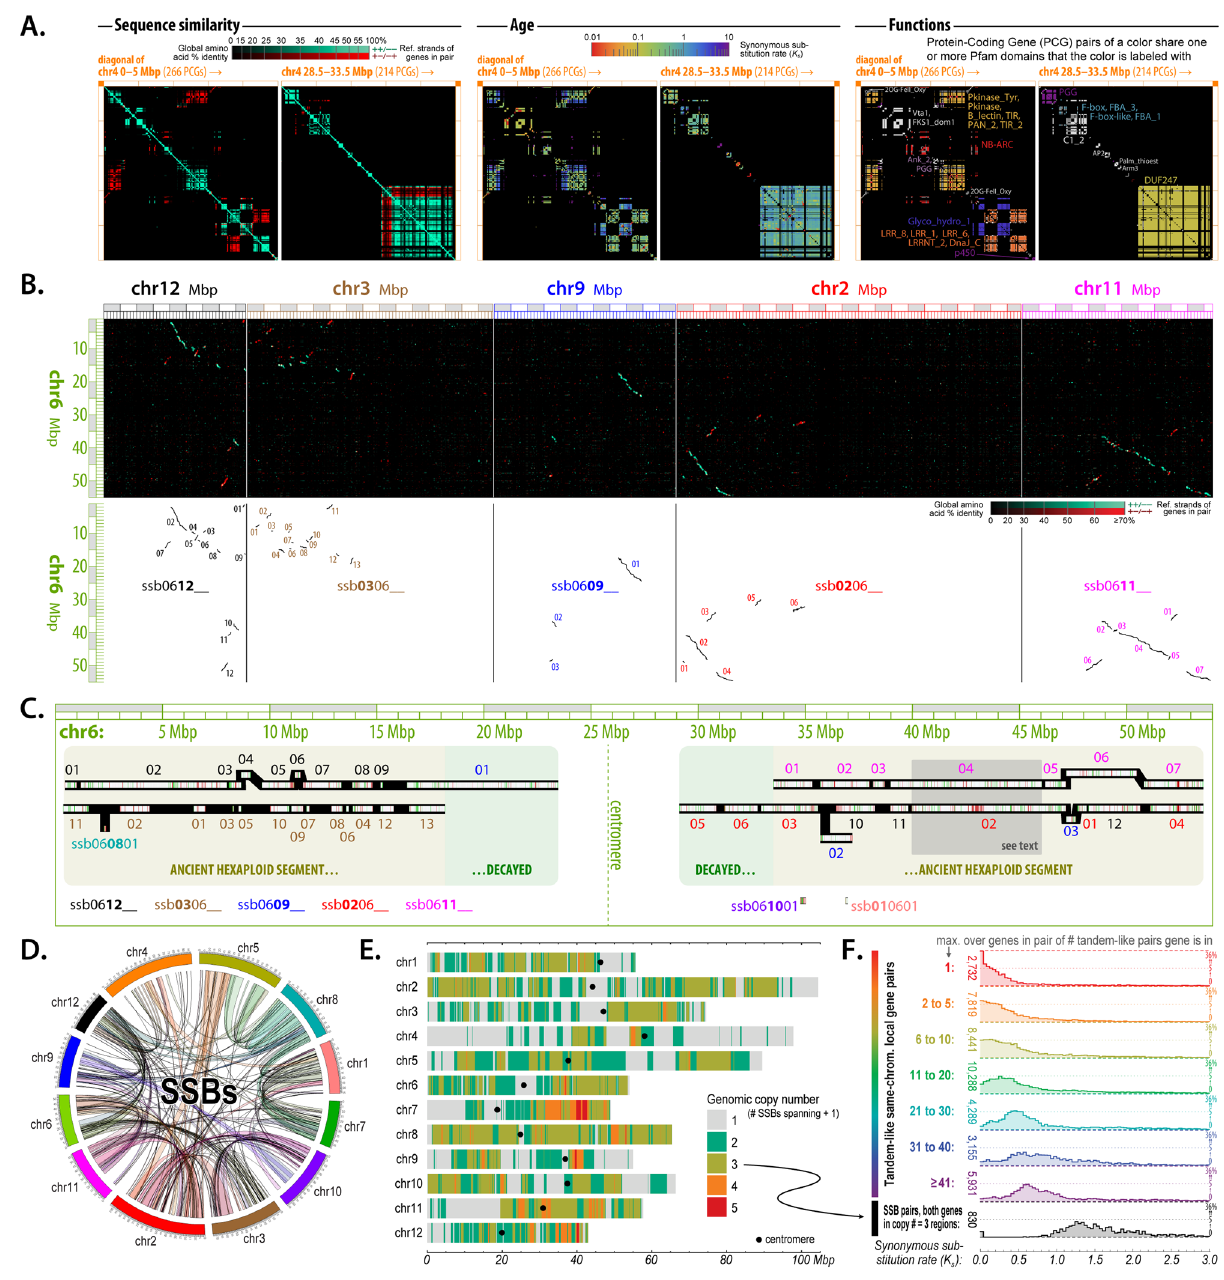
Fig. 4 Duplicated protein-coding genes. A Sequence similarity (amino acid identity), age (synonymous substitution rate K s ), and functions (shared Pfam domains) for all pairs of proteins within two illustrative 5 Mbp regions of chr. 4. The largest block visible includes many DUF247 genes. Nearly half of Q. lobata PCGs are involved in tandem-like blocks of varying sizes (up to Mbp scales and dozens of genes at a time), often locally rearranged, and originating and growing at a variety of ages. Genes involved are diverse but enriched in certain functions. B , C With no recent whole-genome polyploidization, most of the detected PCG syntenies of Q. lobata to itself (SSBs) are small and diffuse and re fl ect the core eudicot triplication event γ over 100 Mya. Despite its age, this event remains quite evident — albeit highly fragmented, dispersed, and partially decayed. The whole of chr. 6 vs. the whole of chr. 12/3/9/2/11 are shown as exemplary. D , E SSBs [even without chaining as in C ] cover much of the chromosomes. The highest fraction (34% of base pairs) is spanned by manifest triplication, 27% by duplication (while some duplication is recent, most appears to be decayed triplication), and 34% by no detected extant synteny. F The pairwise synonymous substitution rate ( K s ) tends to be very low for genes tandemly duplicated just once (red) and increases as tandem-like block size increases (orange to violet), suggesting larger blocks are older. K s is essentially always extremely high ( ≥∼ 1.0) for SSB gene pairs where both pair genes lie in chromosomal regions spanned by exactly two SSBs (black), supporting the syntenic triplications to be of ancient